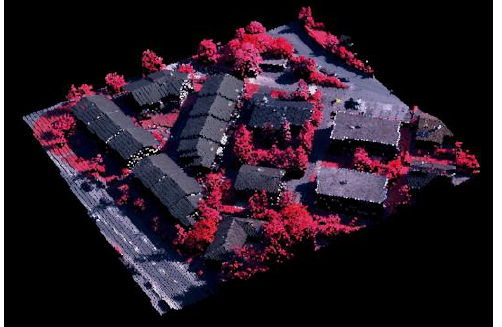
Figure 9. The point cloud rendering results conbining with spectral information in Vaihingen